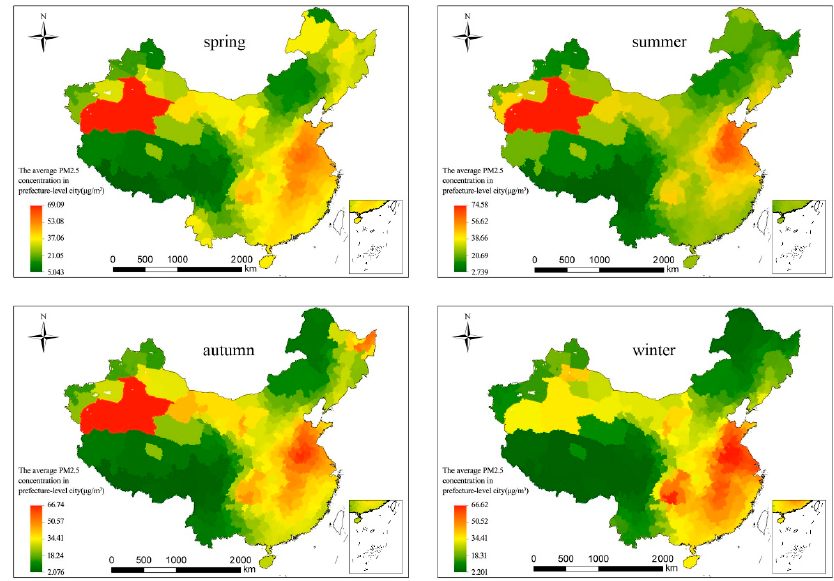
Remote Sens. 2022 , 13 , x FOR PEER REVIEW Figure 3. Local indicators on PM 2.5 spatial association (or LISA) maps of prefecture-level cities in Figure 3. Local indicators on PM 2.5 spatial association (or LISA) maps of prefecture-level cities in China. Figure 3. Local indicators on PM 2.5 spatial association (or LISA) maps of prefecture-level cities in China. China.